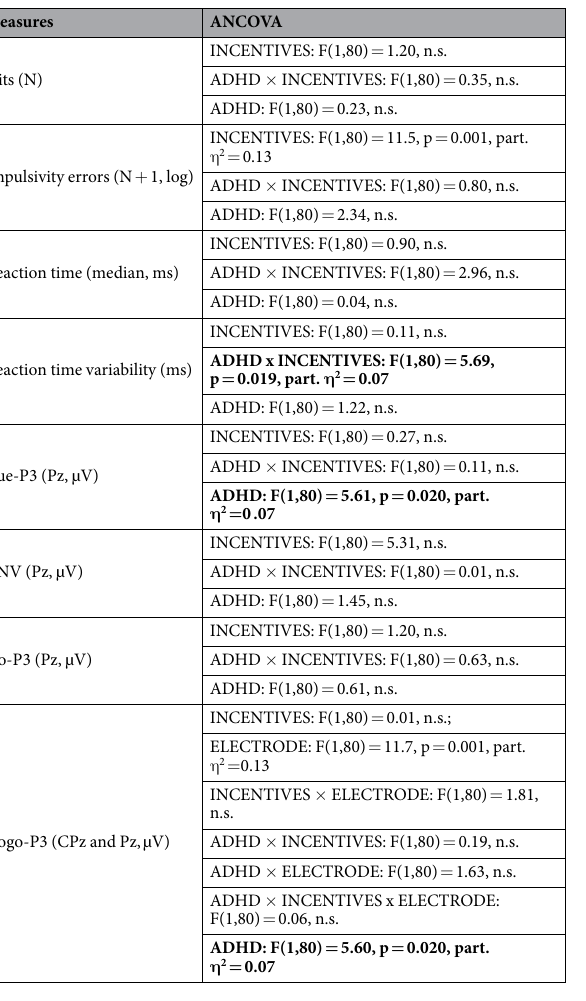
Table 1. Motivational go/nogo task - results of the ANCOVA analyses (main and interaction effects) for the performance measures and ERP amplitudes [covariate ADHD (FBB-ADHS total score), within-subject factors INCENTIVES and ELECTRODE (only for the Nogo-P3)]. Abbreviations: CNV: contingent negative